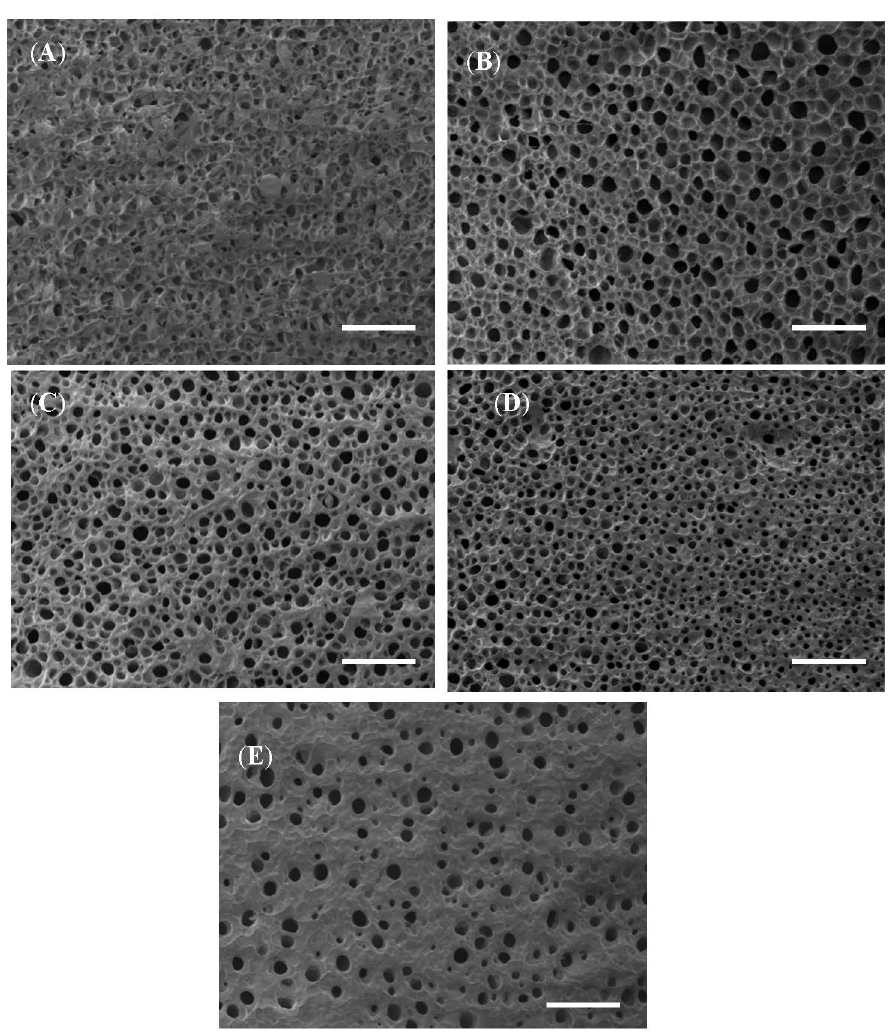
Figure 6. The SEM images of ( A ) normal corn starch hydrogel, ( B ) starch–borax 0.5% DC hydrogel, ( C ) starch–borax 2% DC hydrogel, ( D ) starch–borax 3.5% DC hydrogels, and ( E ) starch–borax 5% DC hydrogel. Bars = 100 µm.